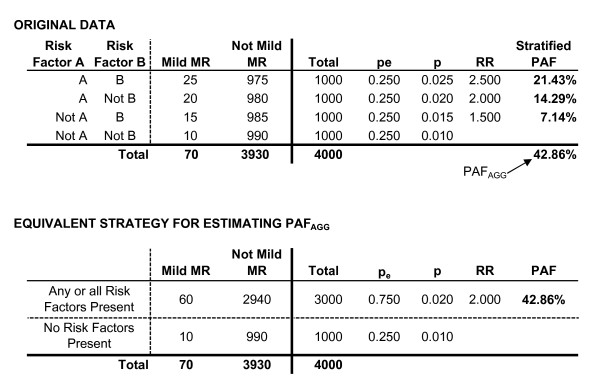
Calculating PAFAGG.